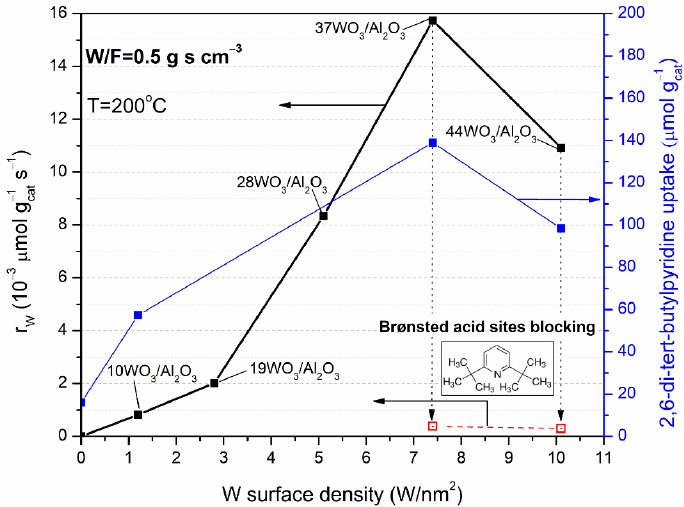
Figure 8. Variation in the reaction rates (in μmol g cat − 1 s − 1 ) of DME hydrolysis of fresh WO 3 /Al 2 O 3 catalysts (solid square symbols, left axis) and poisoned with 2,6-di-tert-butylpyridine prior to catalytic tests (open square symbols, left axis) and 2,6-di-ter-butylpyridine uptake (right axis) with the tungsten surface density. Reaction conditions: 0.09% DME, 3% H 2 O, reaction temperature = 200 °C, W/F = 0.5 g s cm −3 .